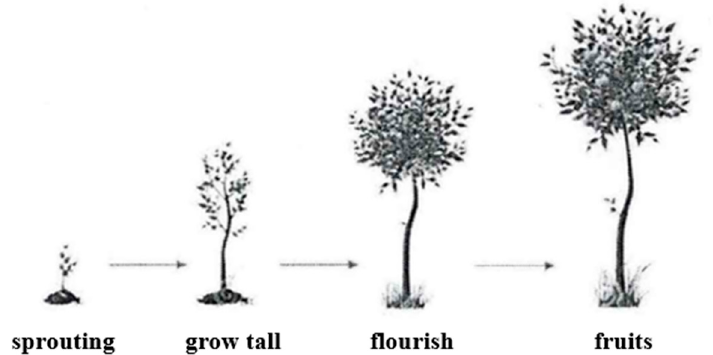
Figure 1. Circular time view manipulation.